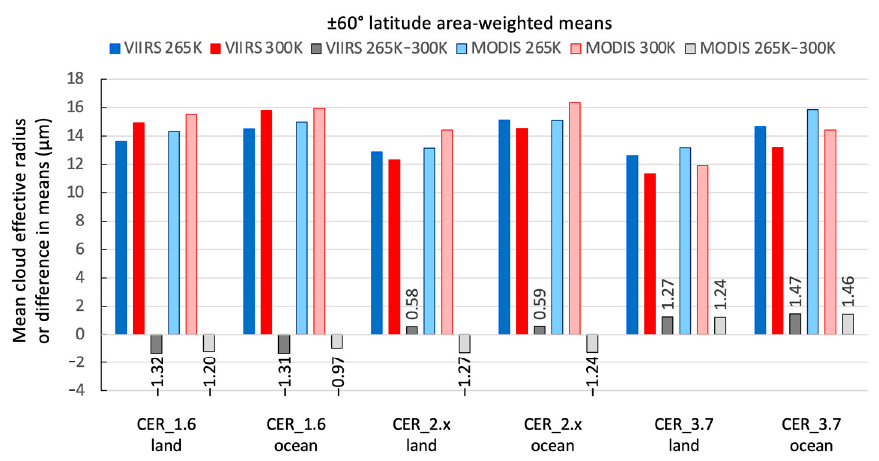
Figure 6. Calculated ± 60 ◦ latitude mean CER from Figure 5 for the 265 K (blue) and 300 K (red) LUTs, and di ff erences (gray shading with value labels). Means for VIIRS (dark red / blue shading) and MODIS (light shading) are given for each SWIR / MWIR retrieval categorized by land and ocean